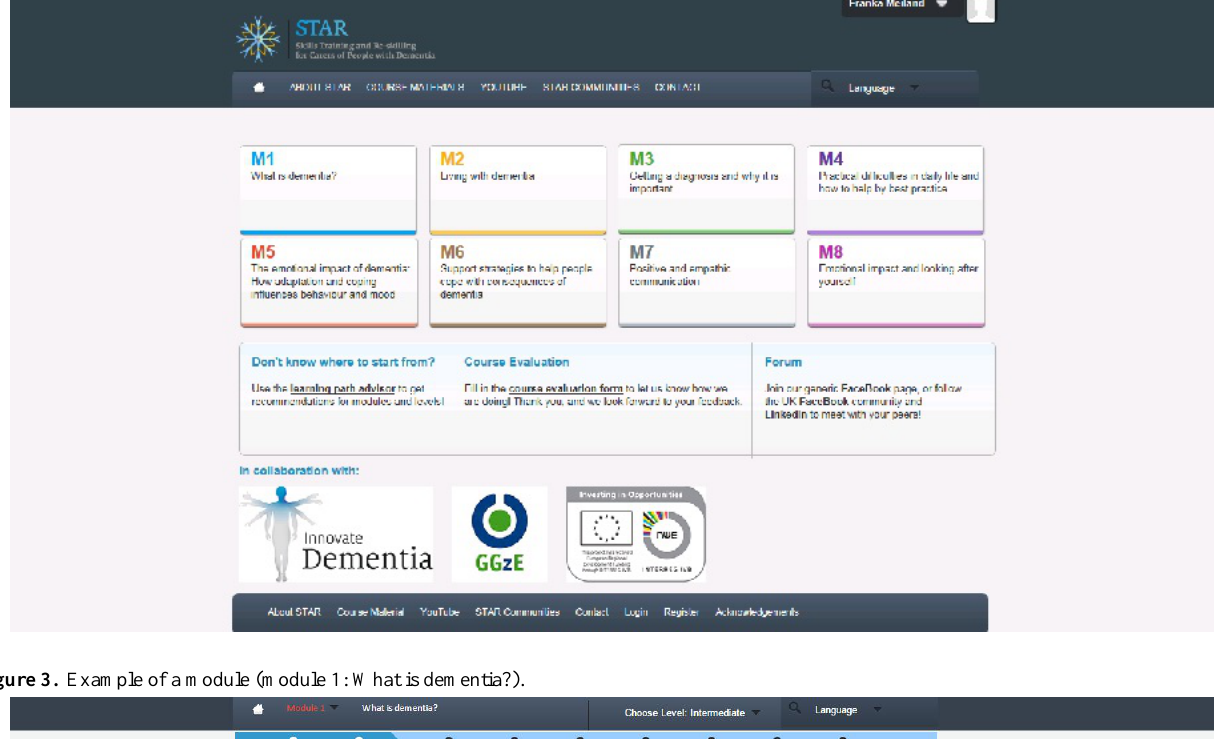
Figure 2. Overview of modules.